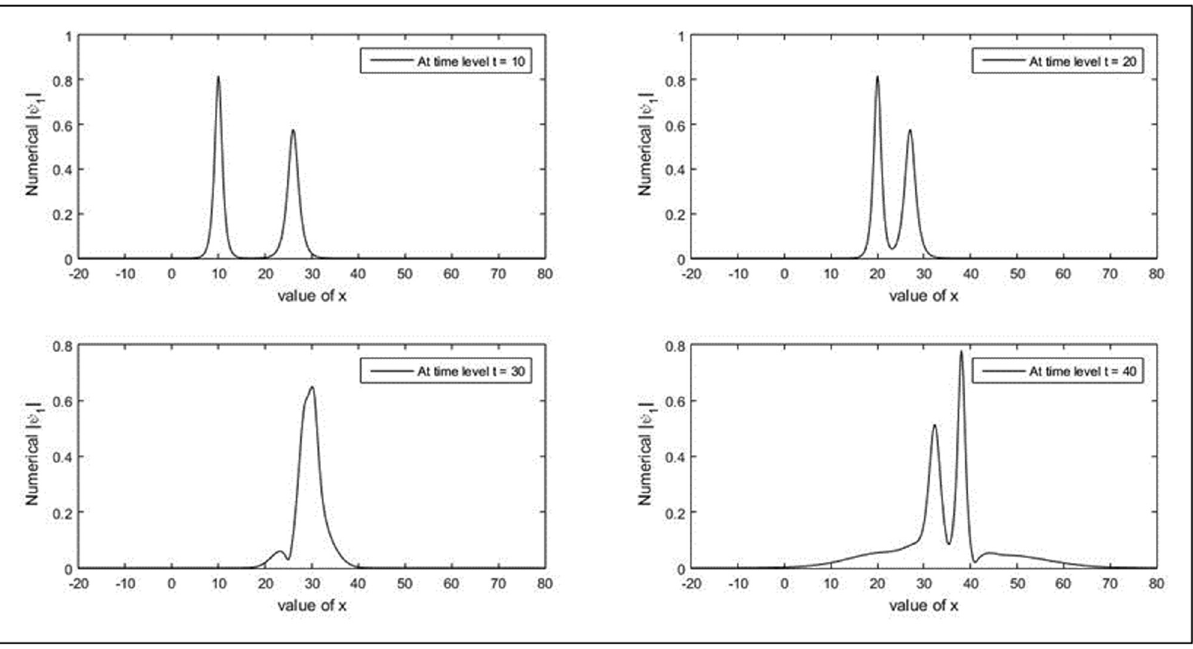
Figure 5: Interaction of two solitons for fi rst - wave amplitude for = N 501